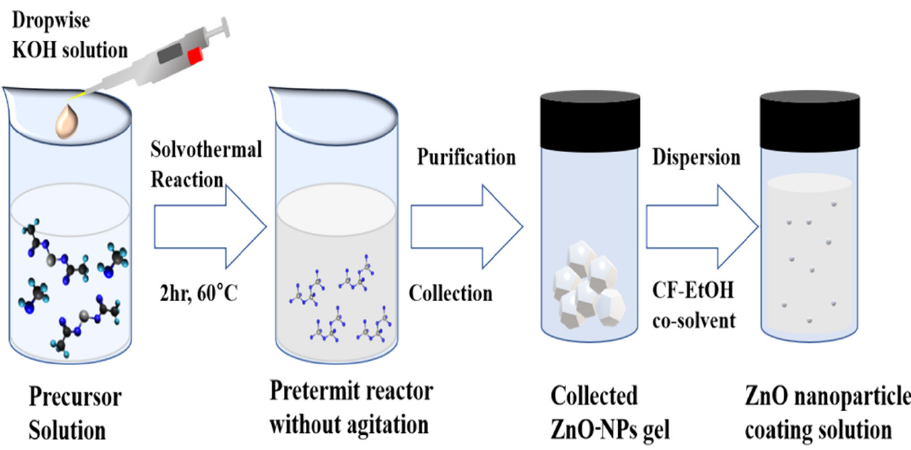
Figure 1. Synthesis process for ZnO-NPs.